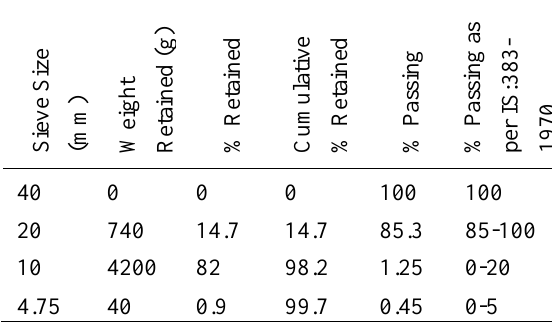
Sieve analysis of coarse aggregate (20 mm down)